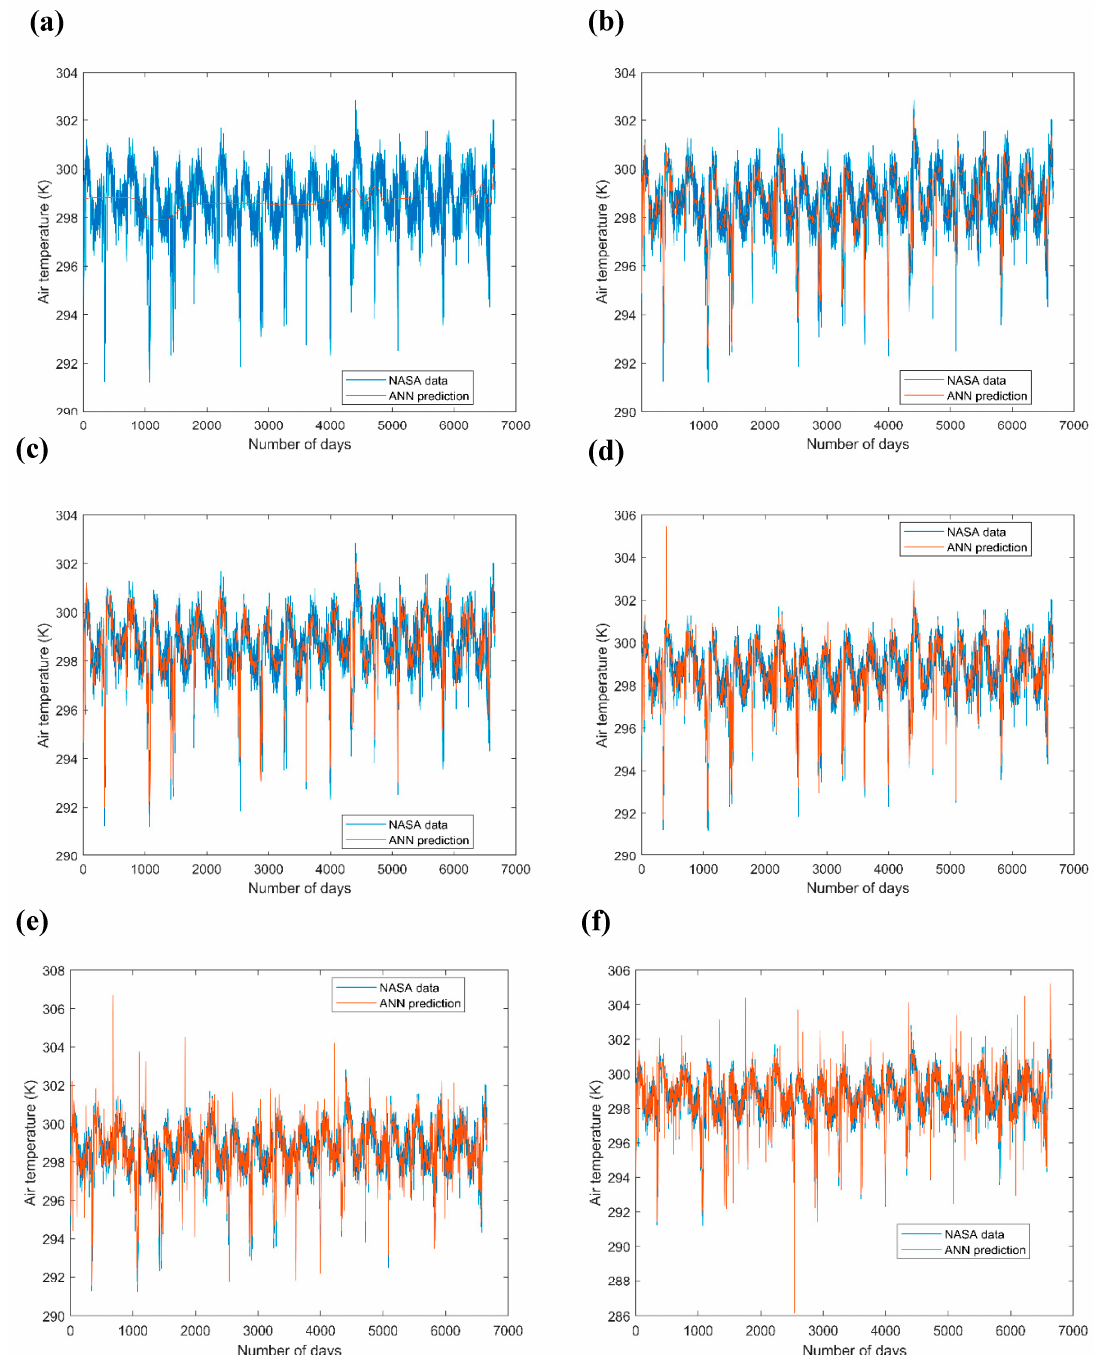
Figure 4. Ambient temperature plot of the NASA data vs. the ANN model with ( a ) 10 hidden units, ( b ) 500 hidden units, ( c ) 1000 hidden units, ( d ) 1500 hidden units, ( e ) 2000 hidden units, and ( f ) 2500 hidden units.